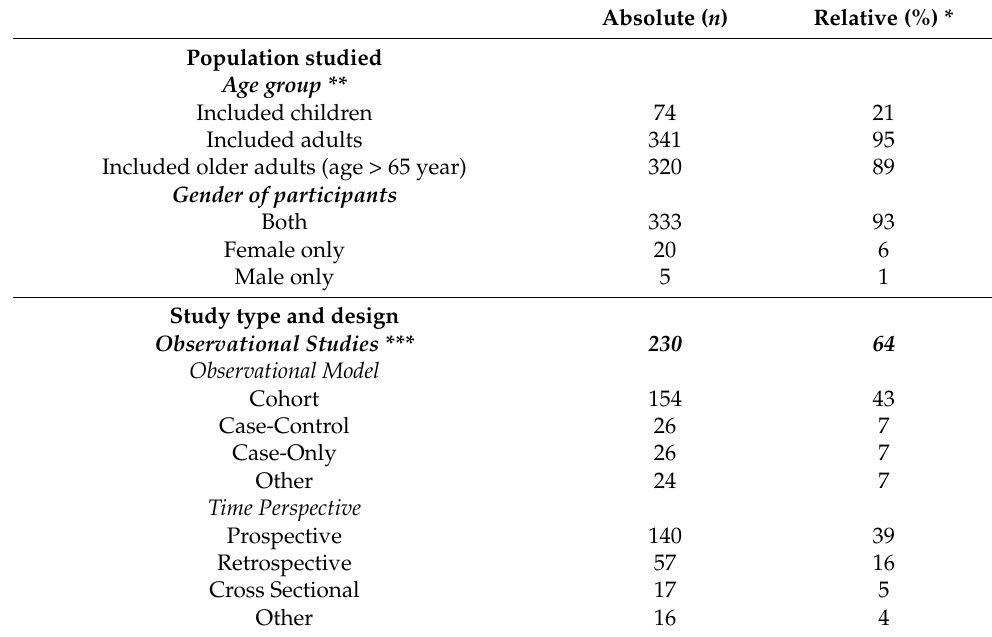
Table 2. Study type and study design specific parameters of the included ML-related clinical trials from the ClinicalTrials.gov registry ( n =